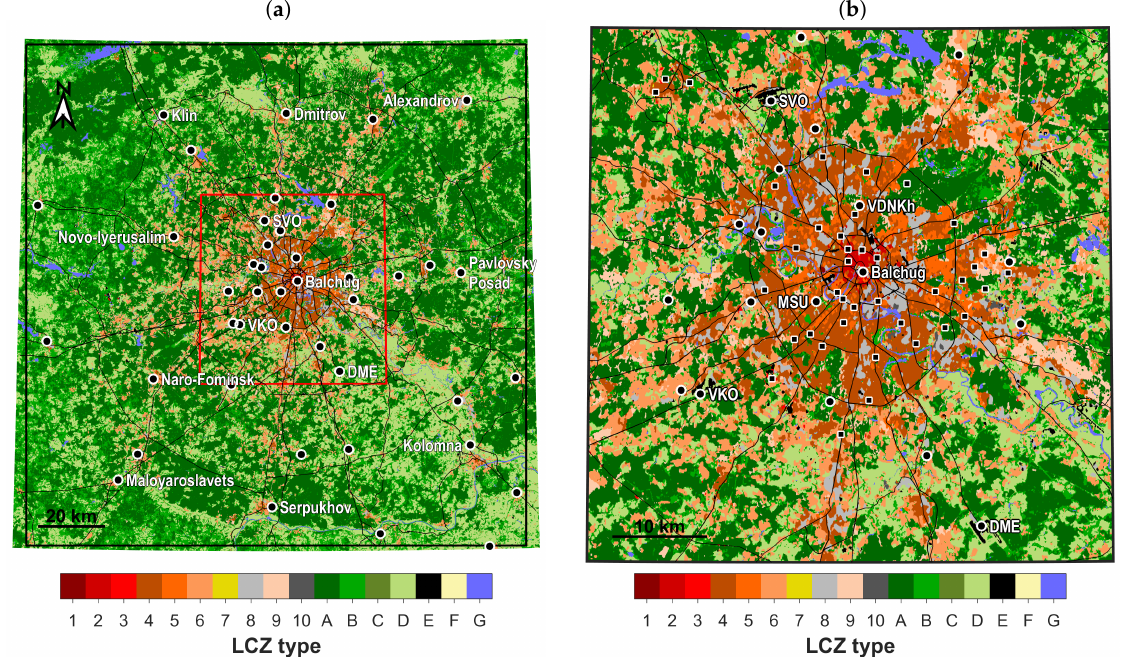
Figure 3. Maps of the Local Climate Zone (LCZ) types for the finest modelling domain ( a ) and for a smaller area around Moscow megacity ( b ) which is shown by red rectangle in ( a ) and used in subsequent